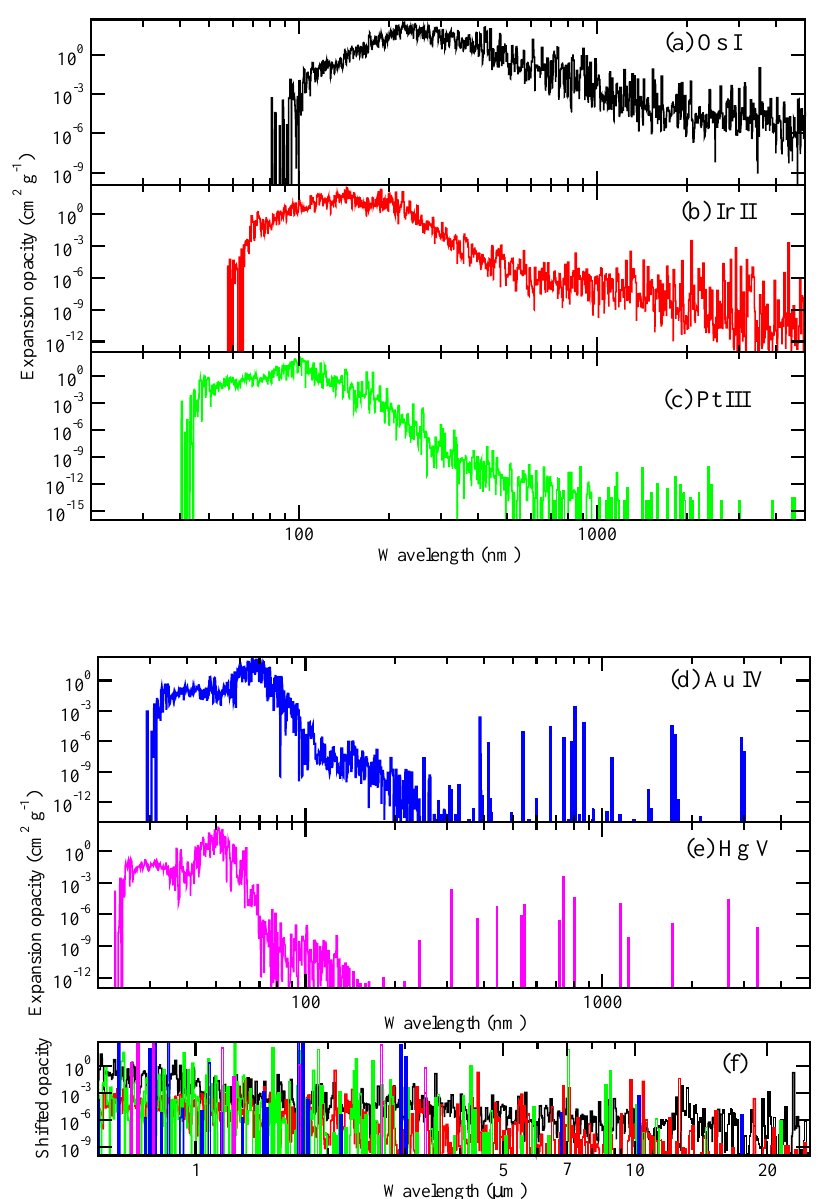
Figure 5. Expansion opacity at 1 day for 3700 K and 10 − 13 g/cm 3 for ( a ) Os I, ( b ) Ir II, ( c ) Pt III, ( d ) Au IV, and ( e ) Hg V using GRASP2K calculations. The opacities in the IR are displayed in ( f ) for all ions but with their magnitudes shifted for